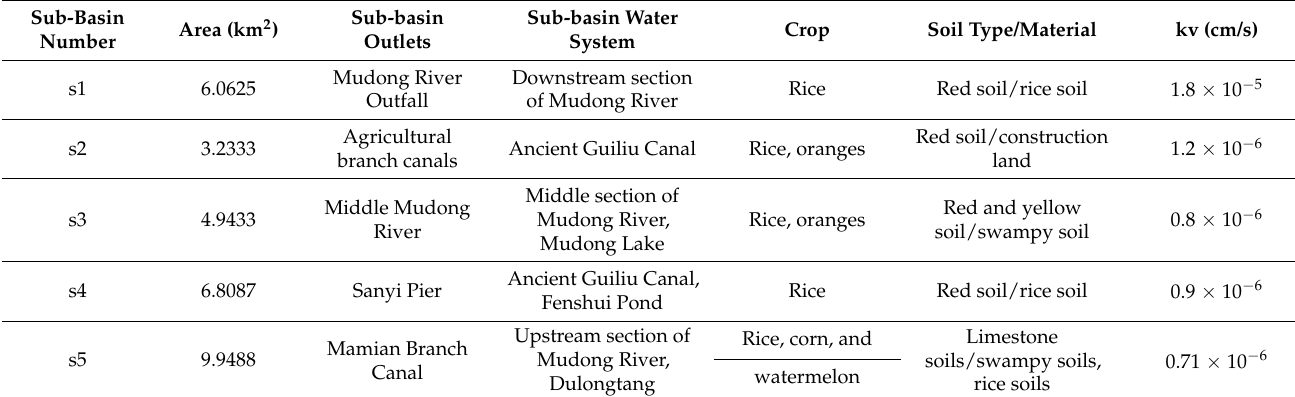
Table 1. Overview of the sub-basins in the study